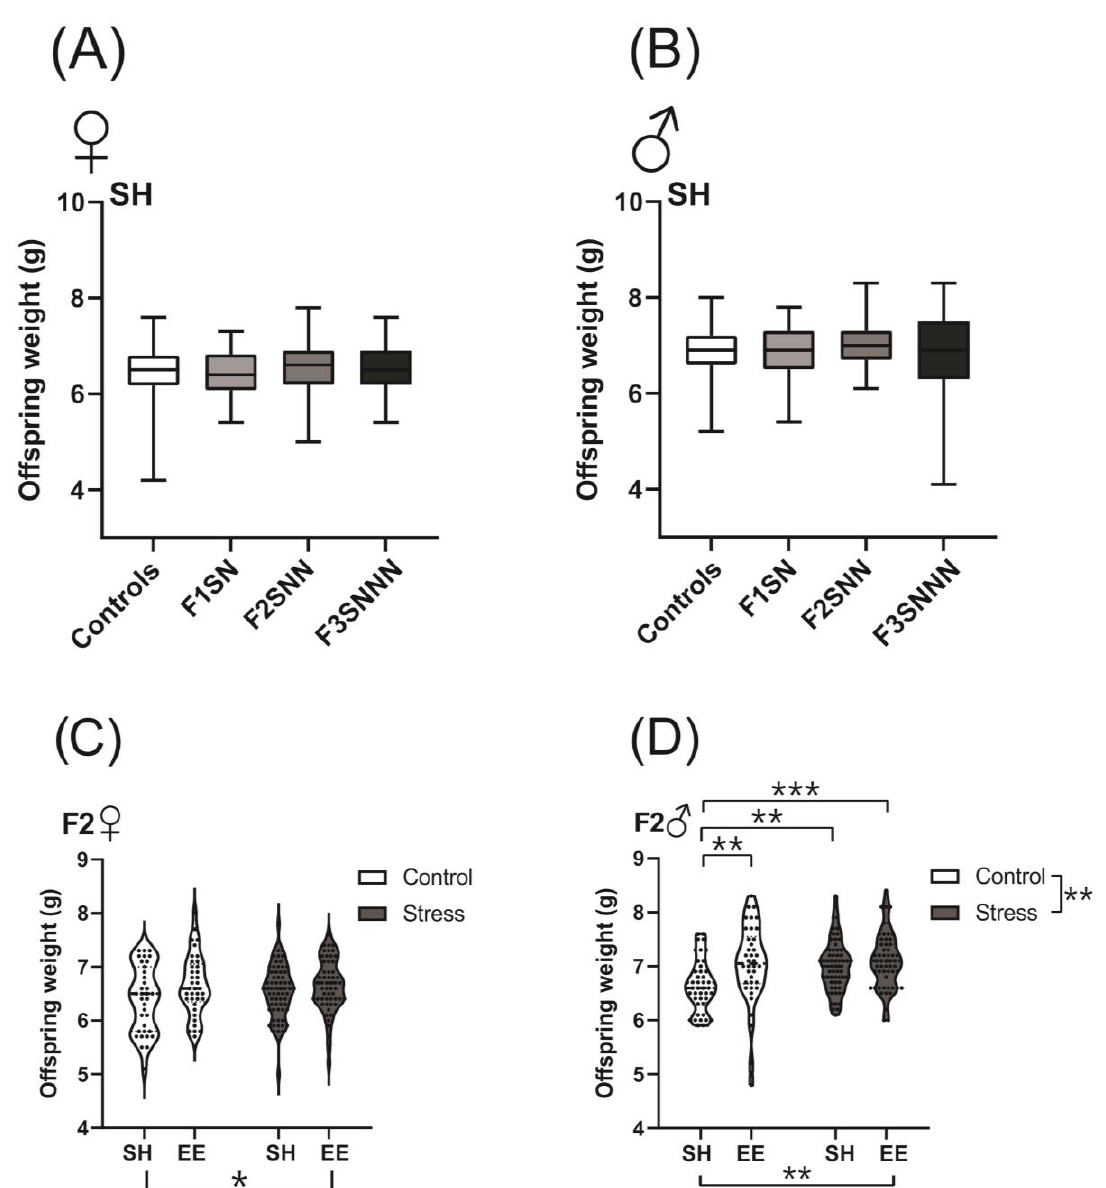
Figure 3. Offspring weights remained unchanged between treatment groups, whereas EE housing significantly increased neonatal birth weights of females and males in the F2 generation. Offspring weights between treatment groups in ( A ) females and (B ) males. Pup weights of control and stressed ( C ) females and ( D ) males subjected to SH or EE housing. Data are compared to F1NN ( A , B ) and F2NNN ( C , D ), mean ± SEM. Box plot mid-lines indicate medians, whiskers indicate min-max values, and boxes indicate interquartile ranges. Kruskal-Wallis test ( A , B ) or two-way ANOVA ( C , D ) analyses were used. SH = standard housing; EE = enriched housing; F = filial generation; S = stressed; N = nonstressed. N = 35–65 (females, A , C ); 38–66 (males, B , D ). Asterisks indicate significance: <0.05 (*); <0.002 (**); <0.001 (***).